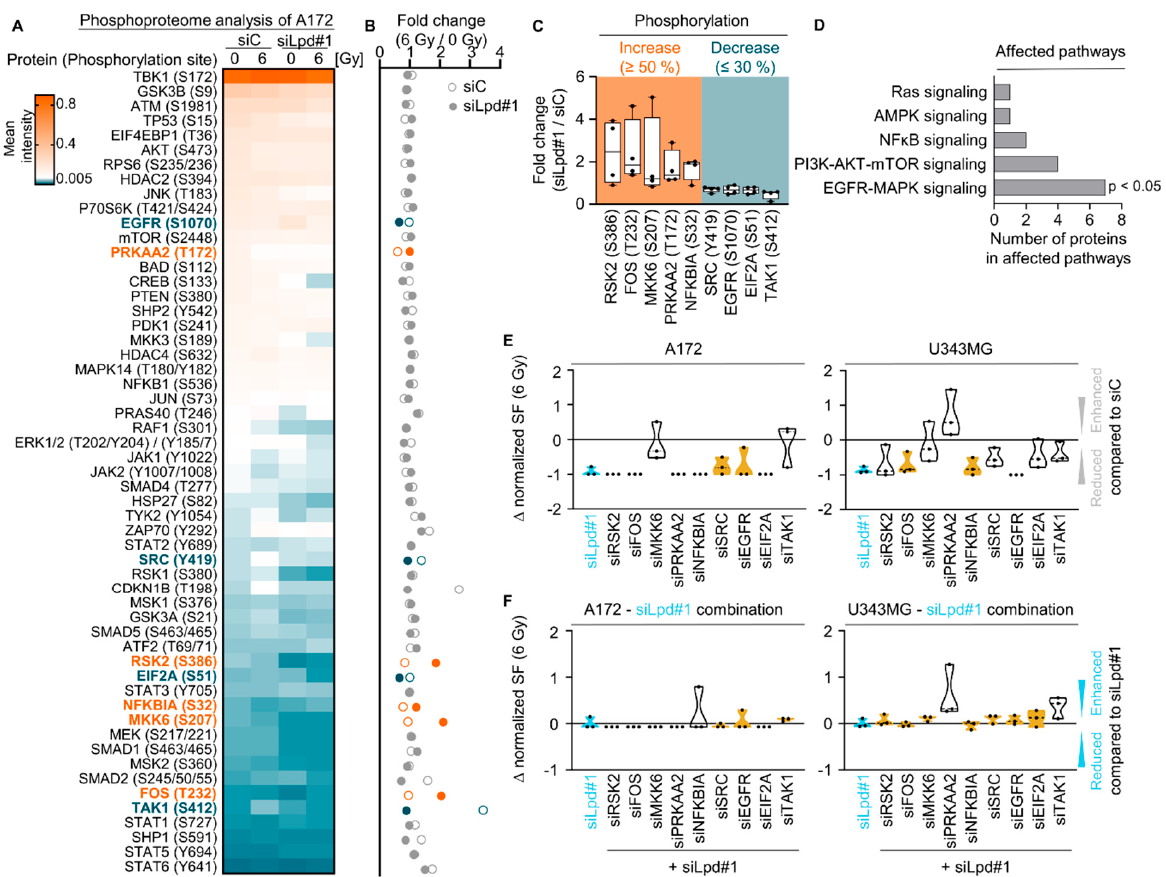
Figure 3. Lamellipodin promotes glioblastoma radiosensitivity via the EGFR-MAPK signaling axis. ( A ) Phosphoproteome analysis showing mean intensity of 55 indicated phosphorylation sites of Lpd or control depleted A172 cell cultures 1 h after 0 Gy or 6 Gy plotted as heat map ( n = 4). Corresponding data are provided in Table S2. ( B ) Fold change in phosphorylation calculated from mean intensity from ( A ) normalized to 0 Gy. Alterations in phosphorylation (fold change) upon Lpd knockdown and 6 Gy compared to control knockdown are categorized as follows: increase ≥ 50% in orange, decrease ≤ 30% in blue. Corresponding data are provided in Table S3. Data are presented as mean ( n = 4). ( C ) Identified proteins showing at least 50% increase or 30% decrease in phosphorylation site changes upon Lpd knockdown and 6 Gy X-ray in comparison to controls from ( B ). ( D ) Affected pathways with altered protein phosphorylation sites after Lpd relative to controls from ( C ). Enrichment of proteins in signaling pathways is indicated with p < 0.05 (Fischer’s exact test). ( E ) Normalized surviving fraction at 6 Gy upon knockdown of the indicated proteins subtracted by control knockdown ( ∆ value) showing differential effects on the surviving fraction of A172 and U343MG cells. Data were normalized to the surviving fraction at 6 Gy of the control knockdown. ( F ) Differences in radiosensitizing effects shown by ∆ values of normalized surviving fraction 6 Gy upon knockdown of the indicated proteins in combination with Lpd knockdown subtracted by Lpd knockdown of A172 and U343MG cells. ∆ value defines altered survival compared to survival of siC ( E ) or siLpd#1 ( F ) and 6 Gy treated cells: <0 reduced survival, 0 unchanged survival, >0 increased survival. Yellow color display equal survival at 6 Gy comparable to Lamellipodin knockdown, whereas white color marks a diverging survival ∆ value. Data are represented as mean ± SD ( n = 3, two-sided Student’s t -test, n .s., not significant, * p < 0.05, ** p < 0.01, *** p < 0.001). si, small interfering RNA; C, control; Lpd, Lamellipodin; SF, surviving